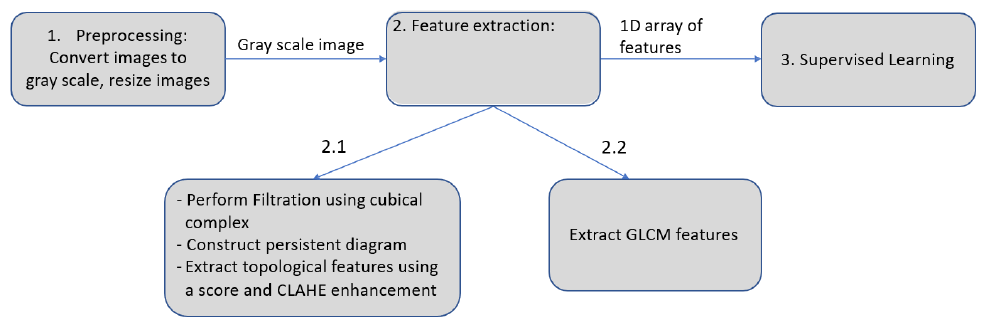
Figure 1. Classification